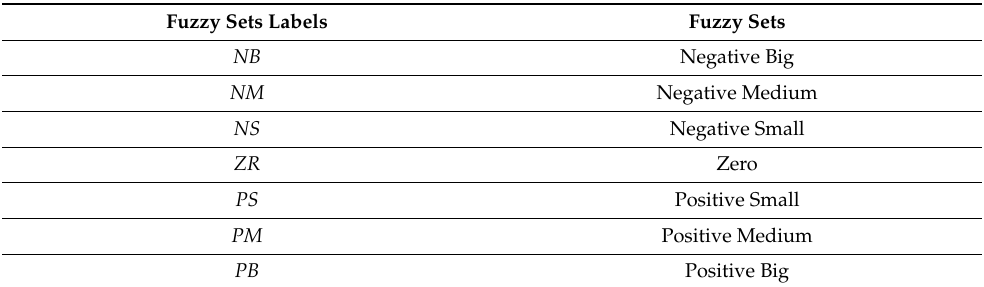
Table 2. Definition of the fuzzy set labels.